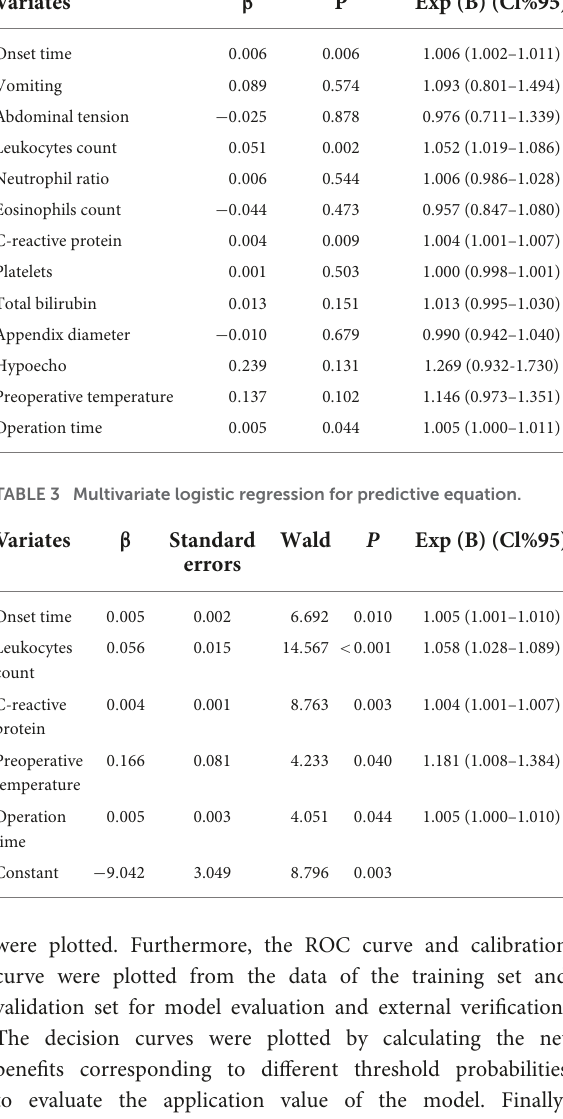
TABLE 1 Comparison of clinical characteristics between the two groups.